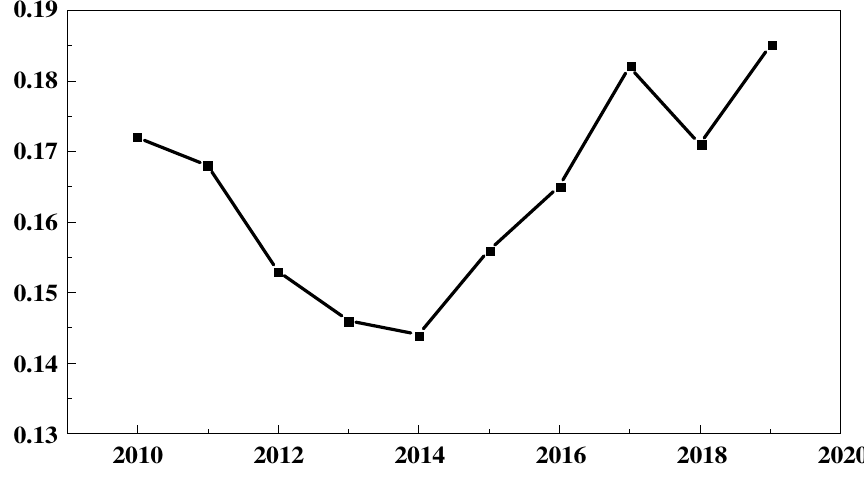
Figure 2. Trends in the standard deviation of environmental performance in China’s power industry from 2010 to 2019.